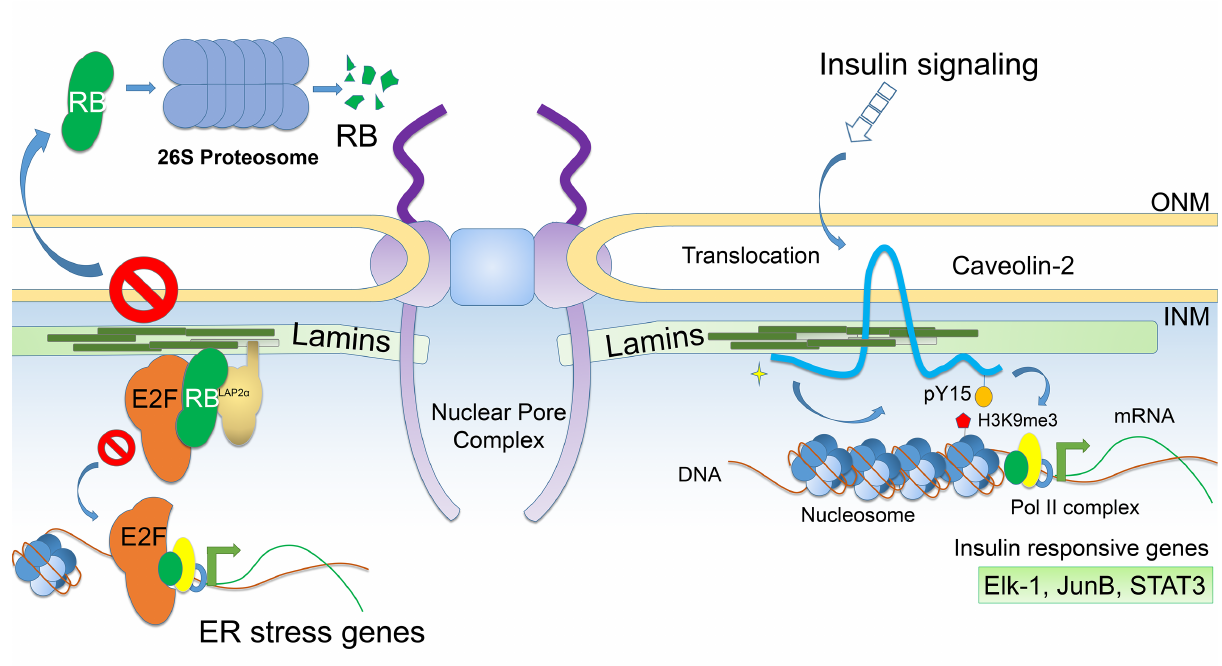
Figure 3. Lamin-associated factors linked to diabetes mellitus (DM). Apart from being implicated in the upstream events that affects insulin production/resistance, nuclear lamins are also suggested in the transcriptional modification of downstream insulin-response and ER stress response machinery through its associated